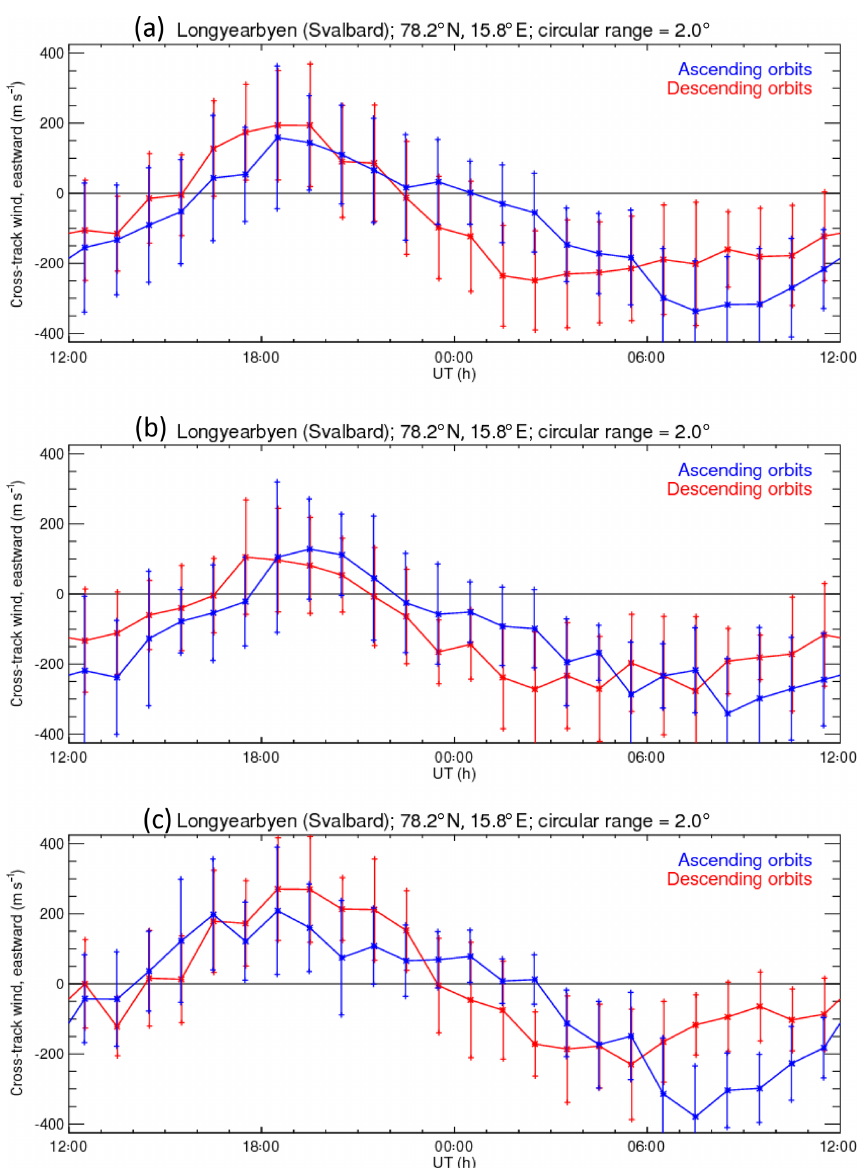
Figure 4. CHAMP observations over Longyearbyen during solar minimum 2005–2007. Panel (a) shows the average values for all data – ascending (blue) and descending (red), panel (b) shows summer (May–August) averages and panel (c) shows winter (end October–early March)